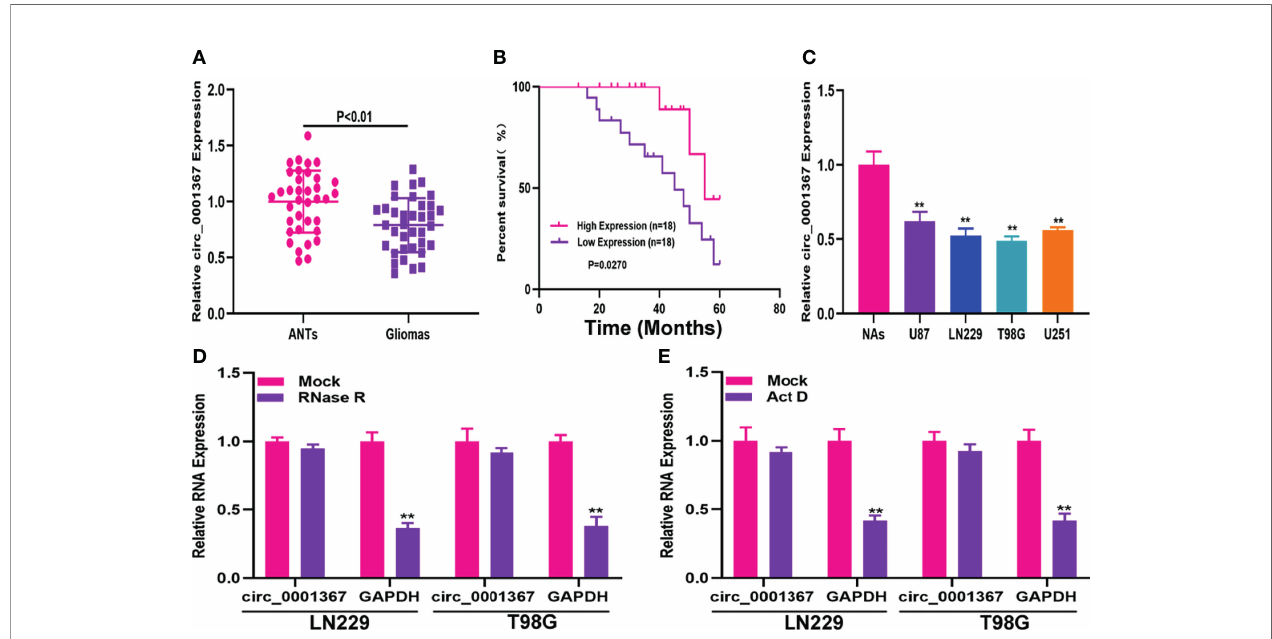
FIGURE 1 | Hsa_circ_0001367 was downregulated in glioma. (A) Expression of hsa_circ_0001367 in glioma tissues and adjacent non-neoplastic tissues (ANTs) detected by qRT-PCR. (B) Survival was compared between patients with high and low levels of hsa_circ_0001367 by Kaplan-Meier analysis. (C) Expression of hsa_circ_0001367 in glioma cell lines and normal human astrocytes (NHAs). (D) Expression of hsa_circ_0001367 and GAPDH in T98G and LN229 cells treated with RNase R or the mock treatment. (E) Expression of hsa_circ_0001367 and GAPDH in T98G and LN229 treated with Actinomycin D (Act D) or Mock. **P < 0.01.